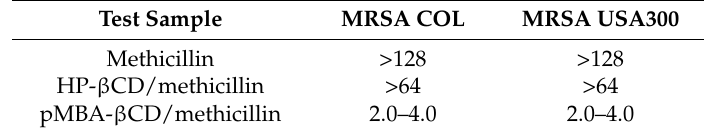
Table 1. Antibacterial activities for methicillin and pMBA- β CD alone and in complex form (MIC, mg/L).